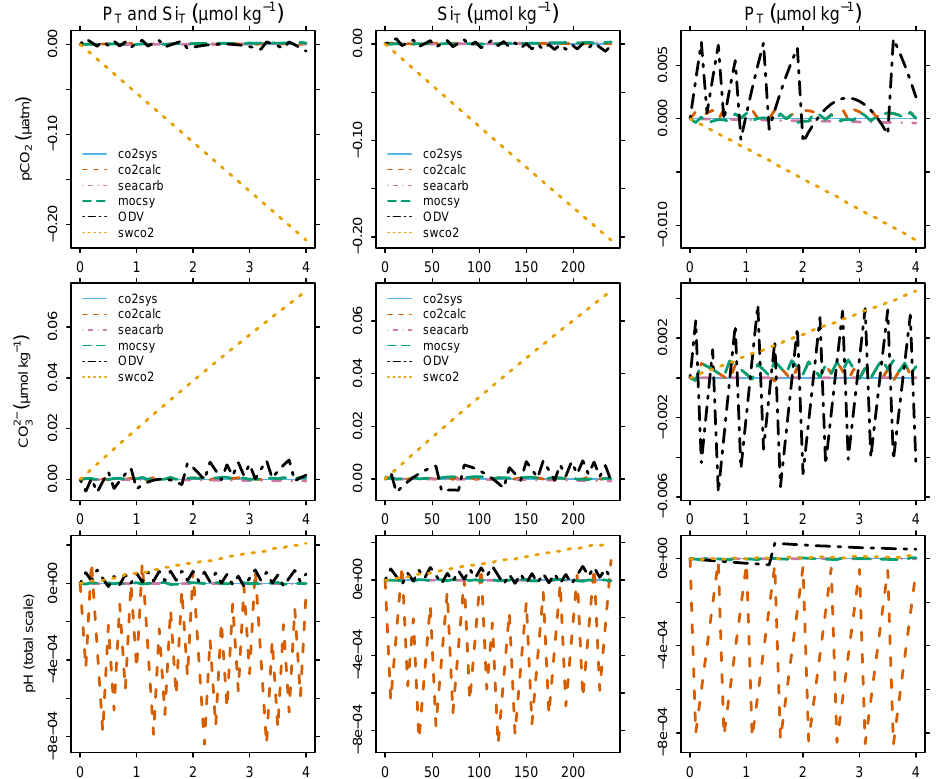
Figure 10. Effect of nutrients on variables computed from A T and C T with each package minus results for CO2SYS-MATLAB. Shown are effects on computed p CO 2 (top), CO 2 − (middle), and pH (bottom) across the observed oceanic ranges of P T (right), Si T (center), and their 3 combined effect (left) for each package. Results from the two CO2SYS Excel variants are not shown, but both agree with the reference. Results for csys are not included as it assumes that nutrient concentrations are always